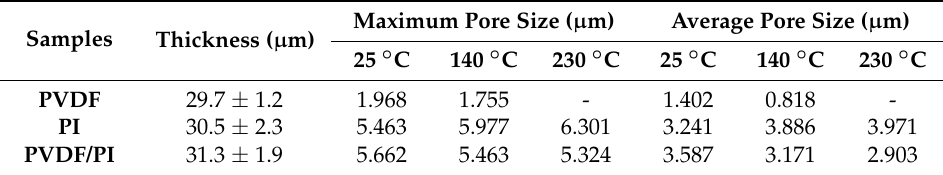
field. Figure S2—fluorescence microscopy images. Green, PVDF fiber; orange, PI